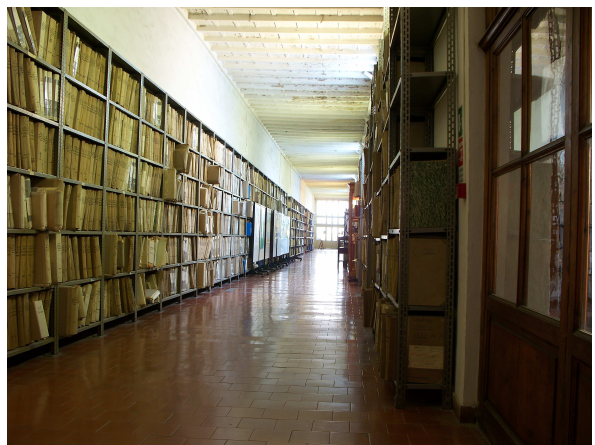
Figure 2. The seat of the Meteorological Archive at